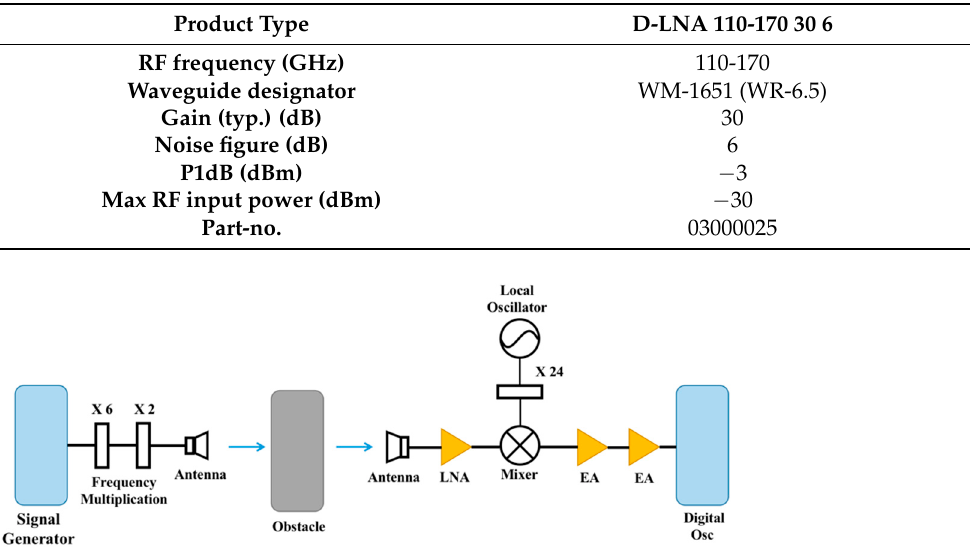
Figure 4. Block diagram of the D-band millimeter-wave transmission experiment system. Table 2. The parameters of LNA.